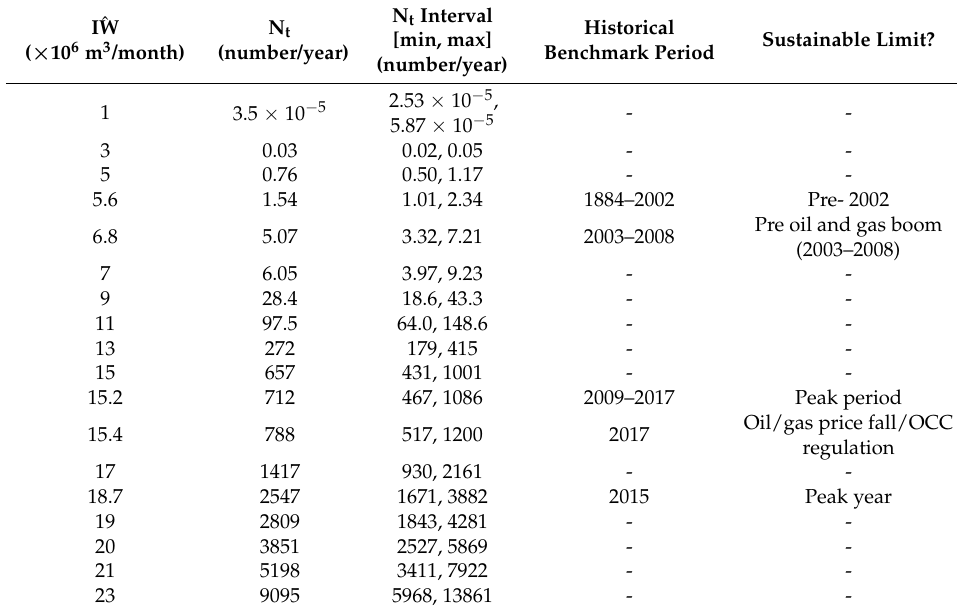
Table 3. Predicting N t (number of earthquakes/year) in terms of hypothetical scenarios of different weighted average ( ˆIW; Equation (2)) or monthly constant IW in light of historical records and benchmark periods. Uncertainty interval estimates have been added to each predicted N t . Historical benchmark periods have been extracted from section 4 this manuscript for reasons of comparison. ˆ